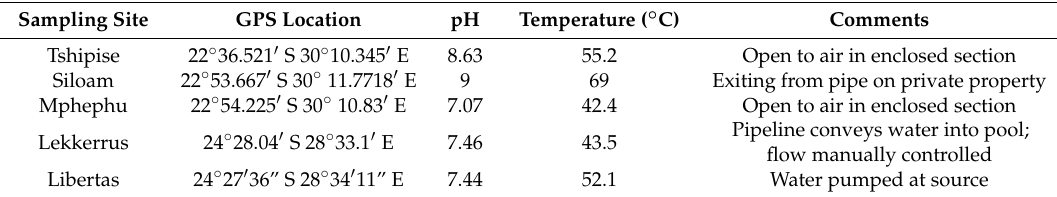
Table 1. Geographical location of sampling sites and sampling